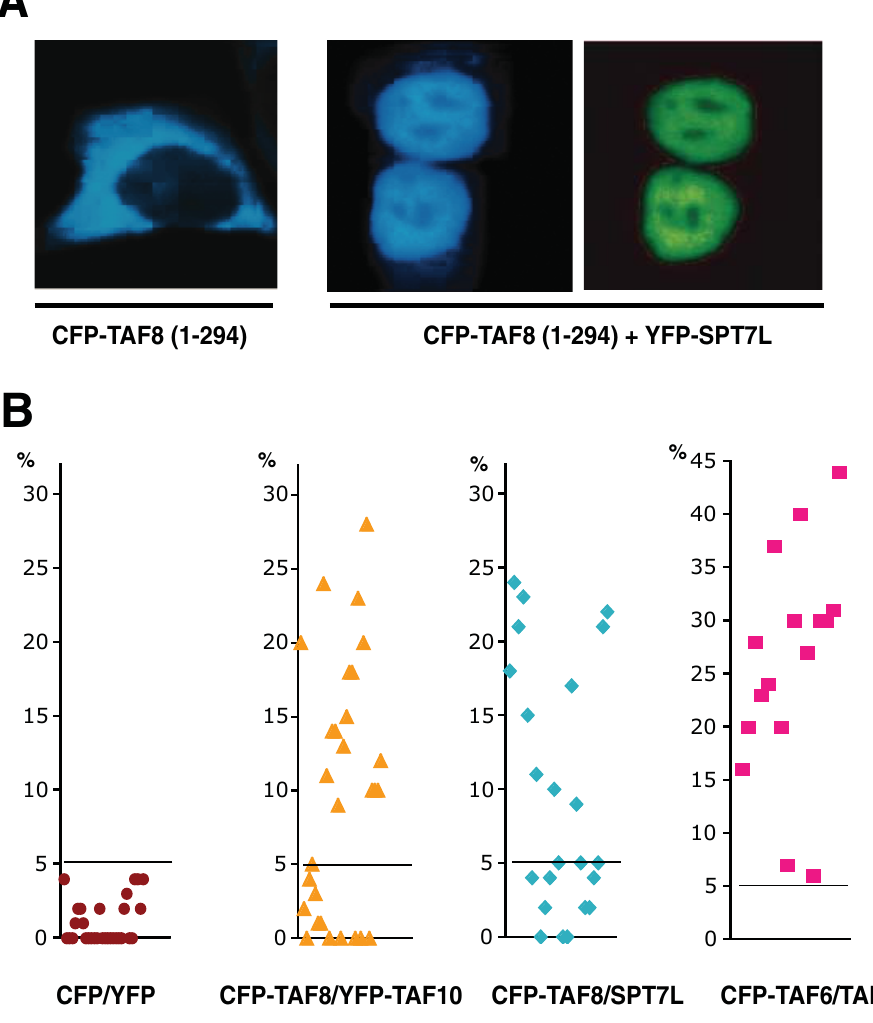
Figure 3. TAF8 and SPT7L interact in vivo (A) The nuclear localization of TAF8 lacking the NLS [TAF8(1-294] depends on its in vivo interaction with SPT7L. HeLa cells were co-transfected with the indicated CFP- and YFP-containing expression vectors and localization of the expressed proteins were visualised by fluorescence microscopy. The images shown in each panel are representative of all the transfected cells. (B) Sensitized emission of YFP fusion proteins due to FRET was measured in two different experiments in the nucleus of 25 individual HeLa cells transfected with the indicated combinations of vectors expressing YFP and CFP fusion proteins. The mean value of FRET efficiency (in%) over the entire nucleus in each cell was calculated as described in the Materials and Methods. A threshold was set to 5%, above the highest value of the negative control CFP/YFP (see horizontal line in each graph), and for the other pairs only values above this level were averaged. The average value of the negative control is 1.03%. The average value for each pair is the following: CFP-TAF8/YFP-TAF10=16.9%; CFP-TAF8/YFP-SPT7L=15.8%; CFP-TAF6/YFP-TAF9=27.1%. Note that the scale for the TAF6/TAF9 is different.